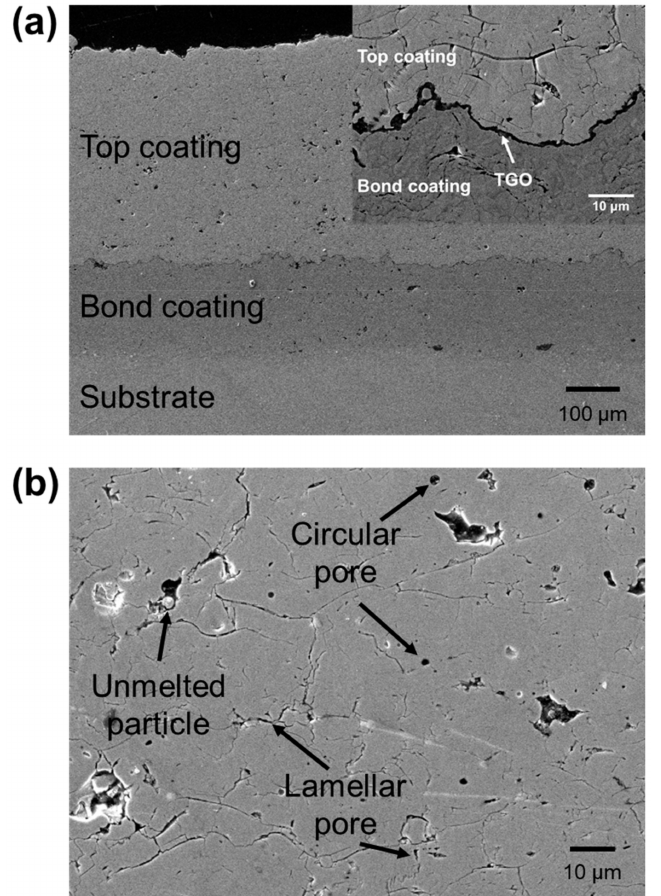
Figure 2. SEM image of TBC cross-section magnified at ( a ) × 200 and ( b ) × 1000. (inset) TGO between top coating and bond